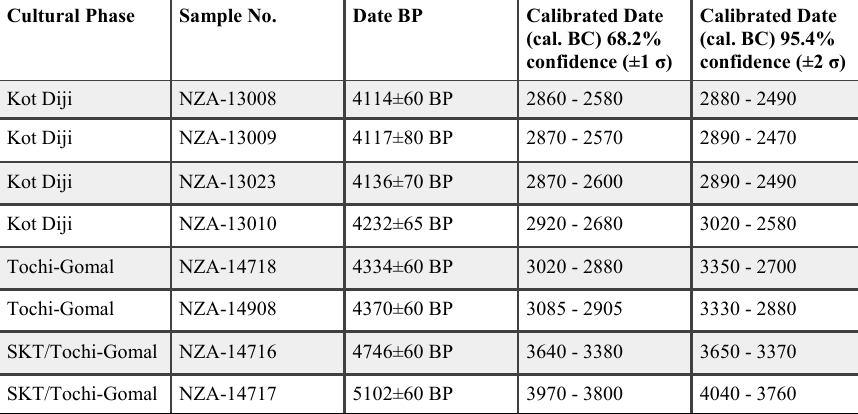
Table 1. Radiocarbon dates for